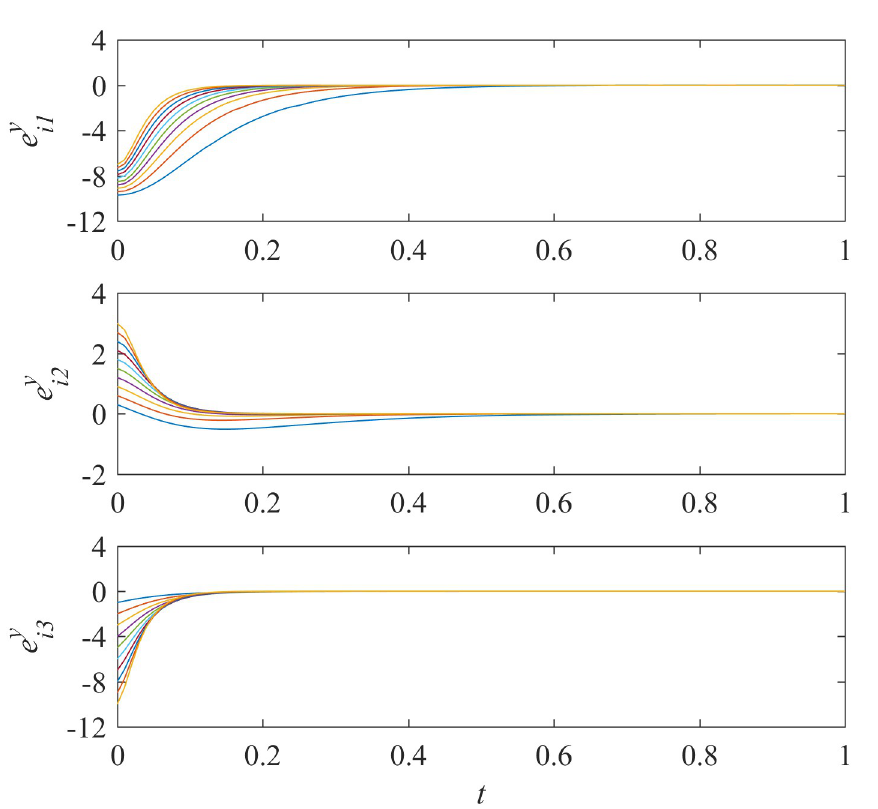
Fig 2. States of error system between the nodes and the isolate node in sub-network Y (Eq (4)).